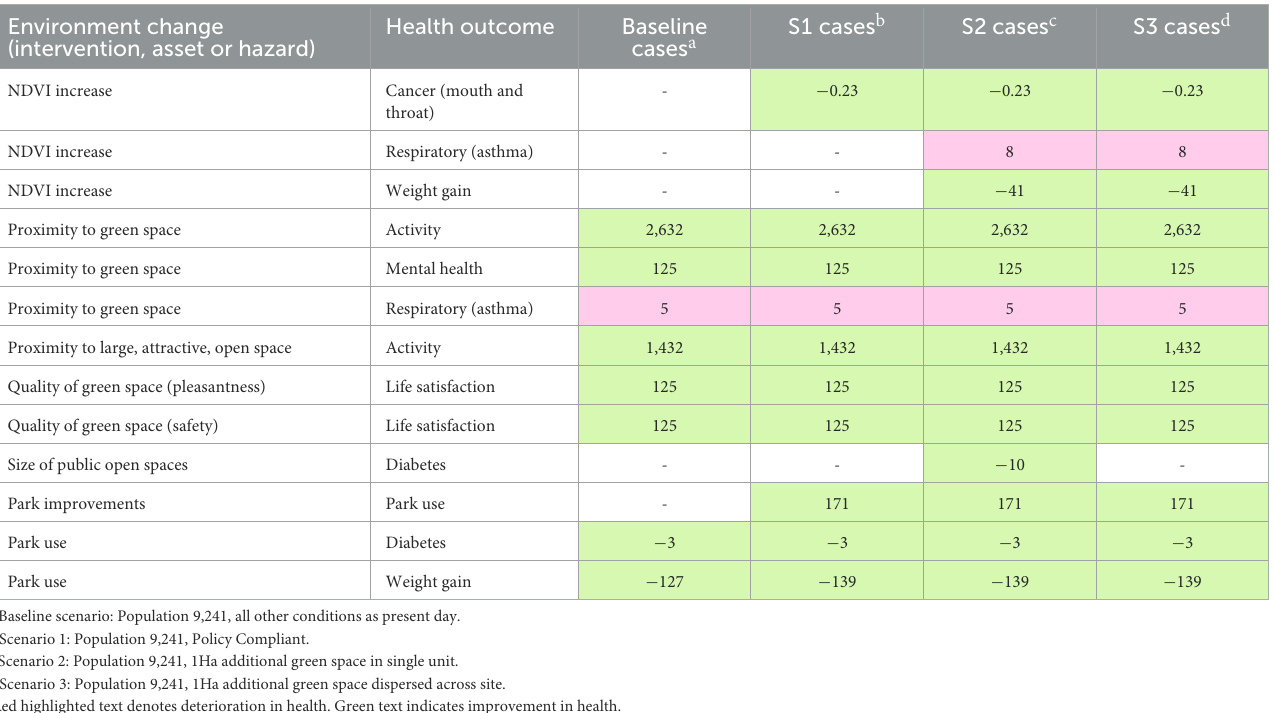
680 premature life years over the lifetime of the project, at a value of around £41.5 million. However, a change in NDVI on this scale represents a dramatic change in the land use at Frome Gateway,